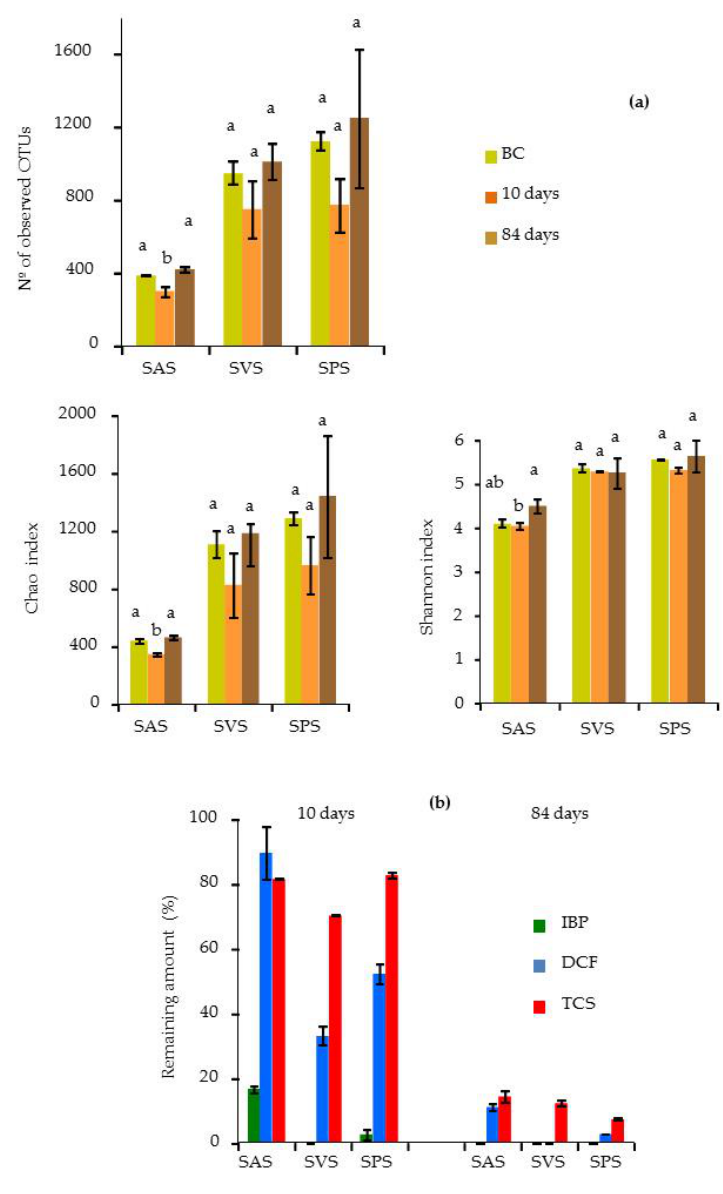
Figure 3. ( a ) Observed OTUs and alpha diversity indices (Chao 1, Shannon) in biopurification sys- tems composed of SAS, SVS and SPS biomixtures, before the contamination (BC) and at 10 and 84 d after the addition of the PPCPs. Different letters in the same biomixture refer to significant differ- ences among times ( p < 0.01). ( b ) Percentage of each PPCP remaining in the SAS, SVS and SPS